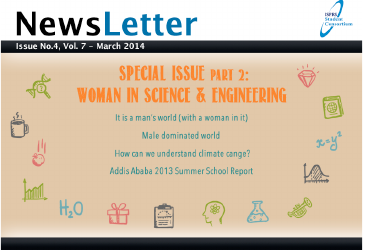
Figure 6. Cover page of the ISPRS SC newsletter Vol.7, Issue No.4 – March